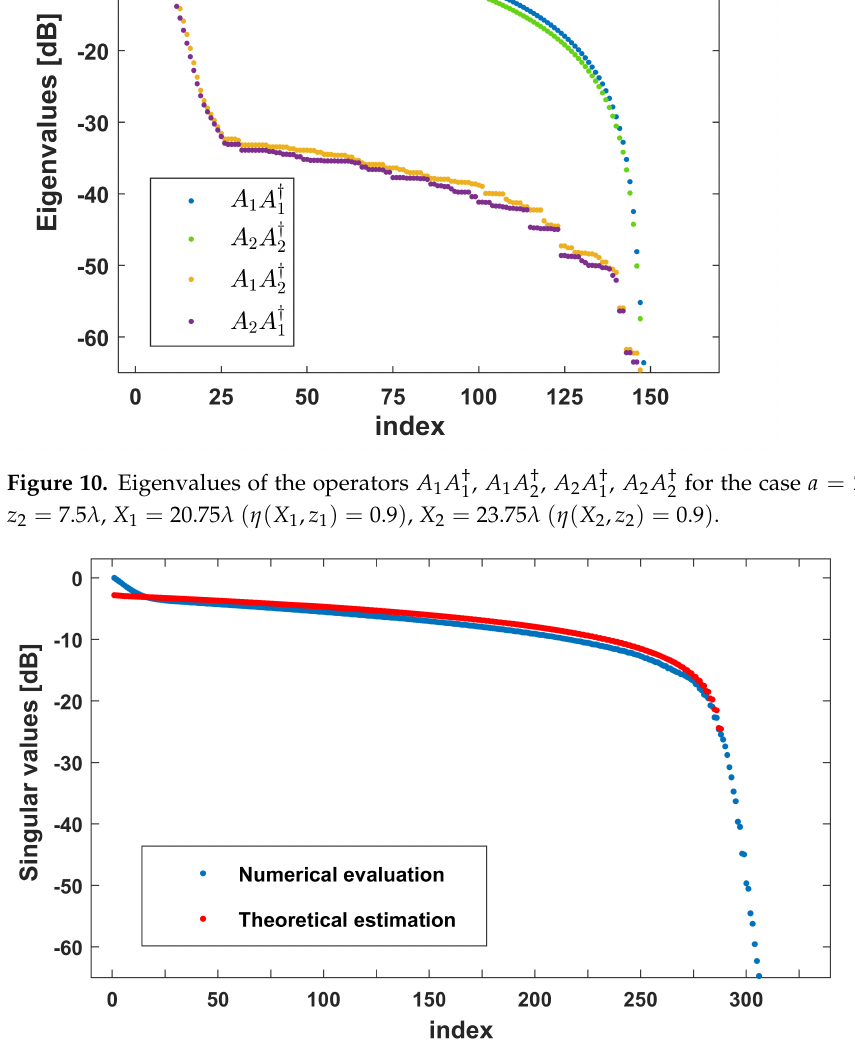
Figure 11. Singular values of A numerically computed, and their analytical estimation for the case a = 20 λ , z 1 = 5 λ , z 2 = 7.5 λ , X 1 = 20.75 λ ( η ( X 1 , z 1 ) = 0.9 ) , X 2 = 23.75 λ ( η ( X 2 , z 2 ) = 0.9 ) . A final test case has been done for the configuration z 1 = 5 λ , z 2 = 7.5 λ , X 1 = 37.03 λ ( η ( X 1 , z 1 ) = 0.99), X 2 = 50.97 λ ( η ( X 2 , z 2 ) = 0.99). Hence, with respect to the